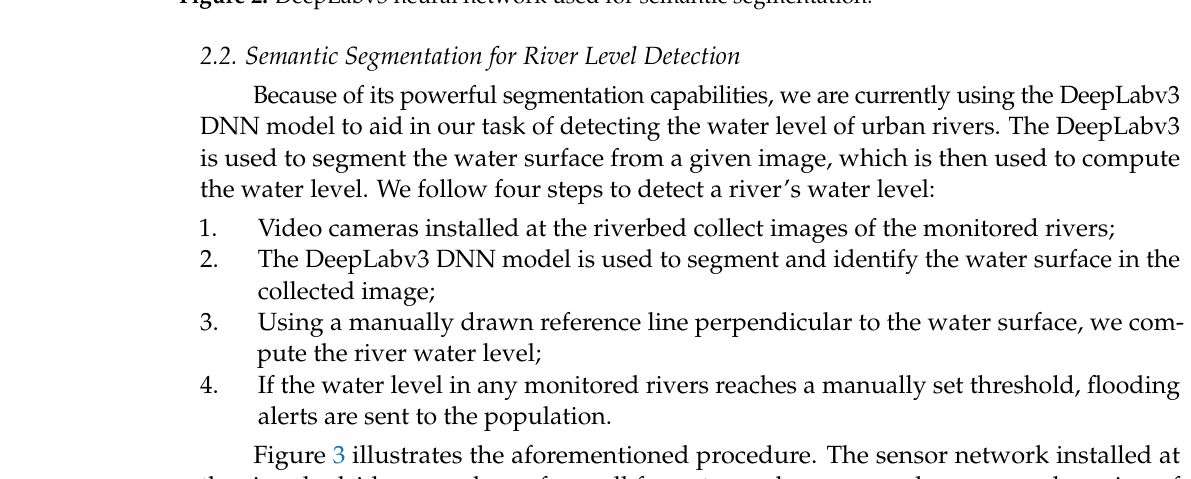
Figure 2. DeepLabv3 neural network used for semantic